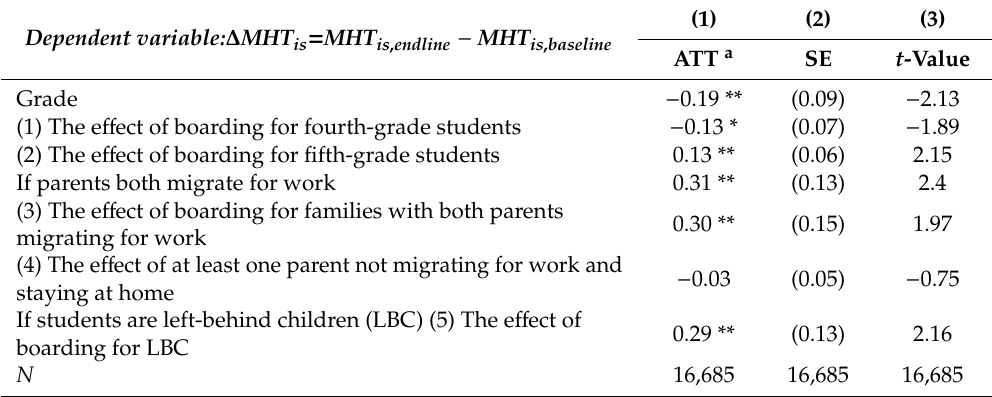
Table 5. The e ff ect of boarding on the mental health of students from di ff erent